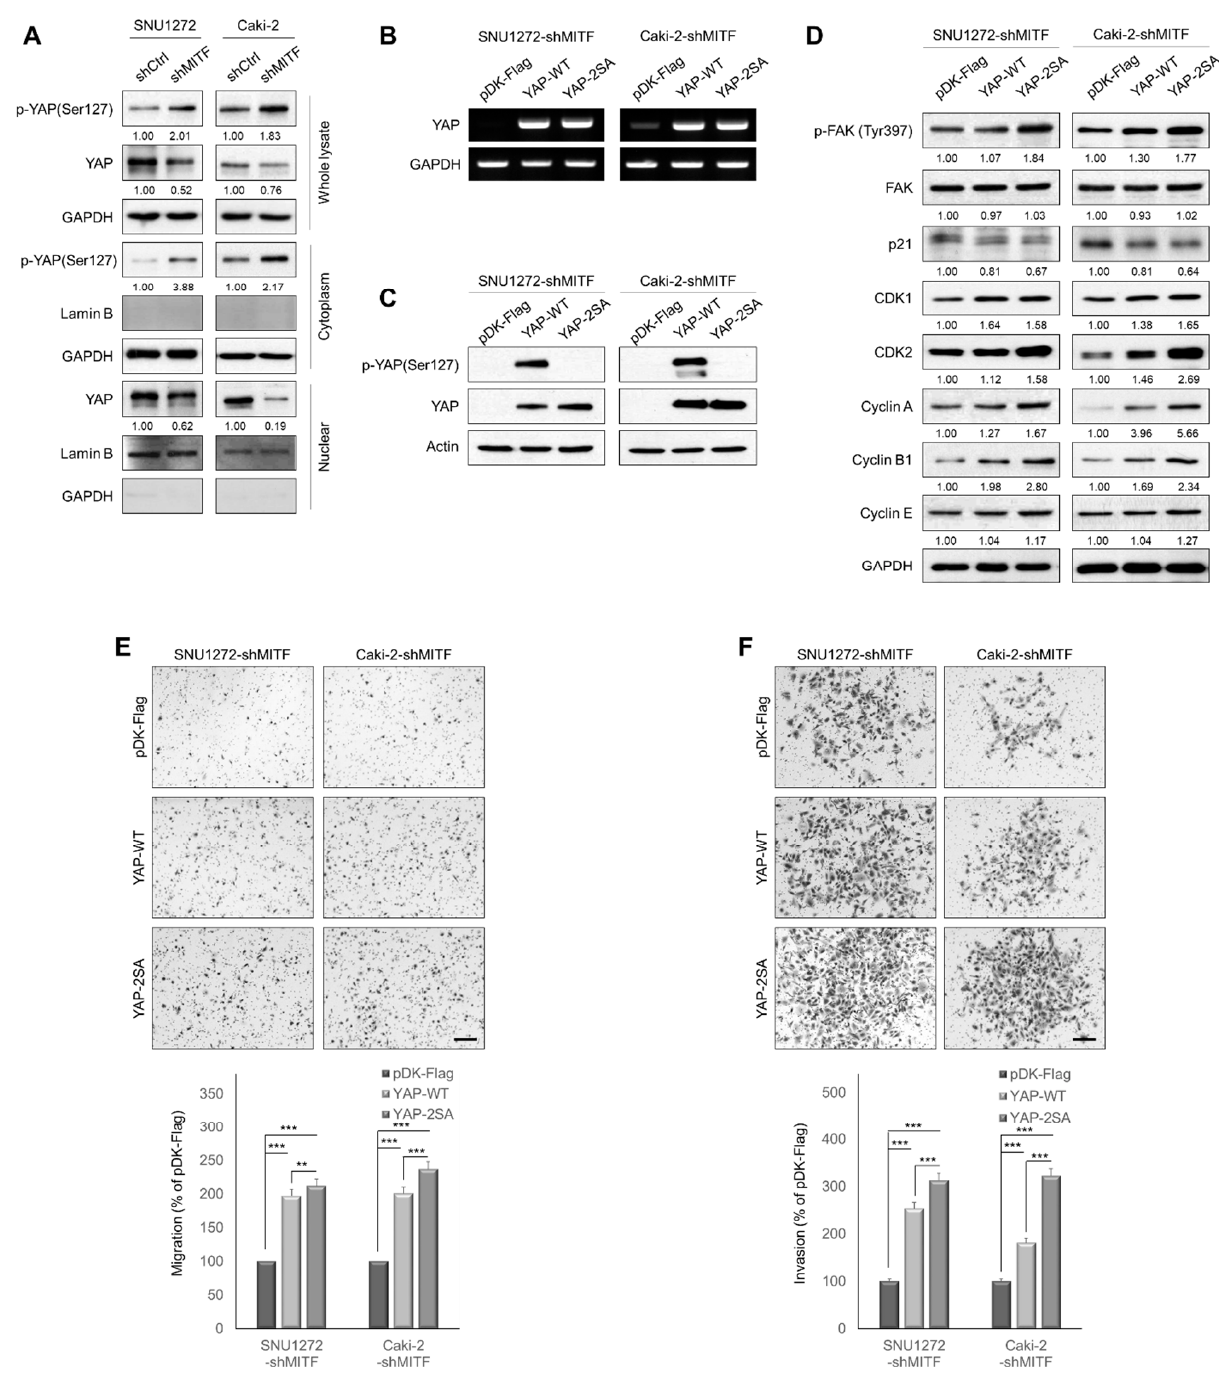
Figure 3. MITF-knockdown inhibits YAP nuclear translocation. ( A ) Western blot analysis of nuclear and cytoplasmic YAP and phosphorylated YAP in MITF-knockdown cells compared with shCtrl cells. Whole areas were measured using Image J software ( n = 3). Uncropped blots are shown in Figure S7. ( B , C ) YAP overexpression levels were determined by Western blot analysis and RT-PCR in MITF-knockdown cell lines. Uncropped blots are shown in Figure S7. ( D ) Western blot analysis of cell cycle-related proteins. Whole areas were measured using Image J software ( n = 3). Uncropped blots are shown in Figure S7. ( E , F ) Transwell migration and invasion assay showing that YAP overexpression restored cell migration and invasion suppressed by MITF knockdown. The number of cells in five randomly chosen fields was counted. Data are presented as the means ± standard deviation by one-way ANOVA ( n = 3). Scale bar, 200 µm. **, p < 0.01; ***, p < 0.001.